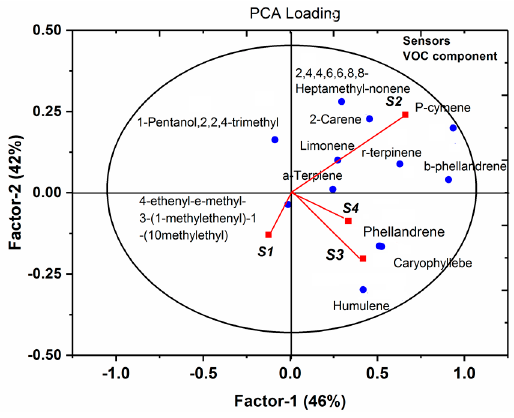
Figure 12. PCA loading plot between the sensors and VOCs compounds.